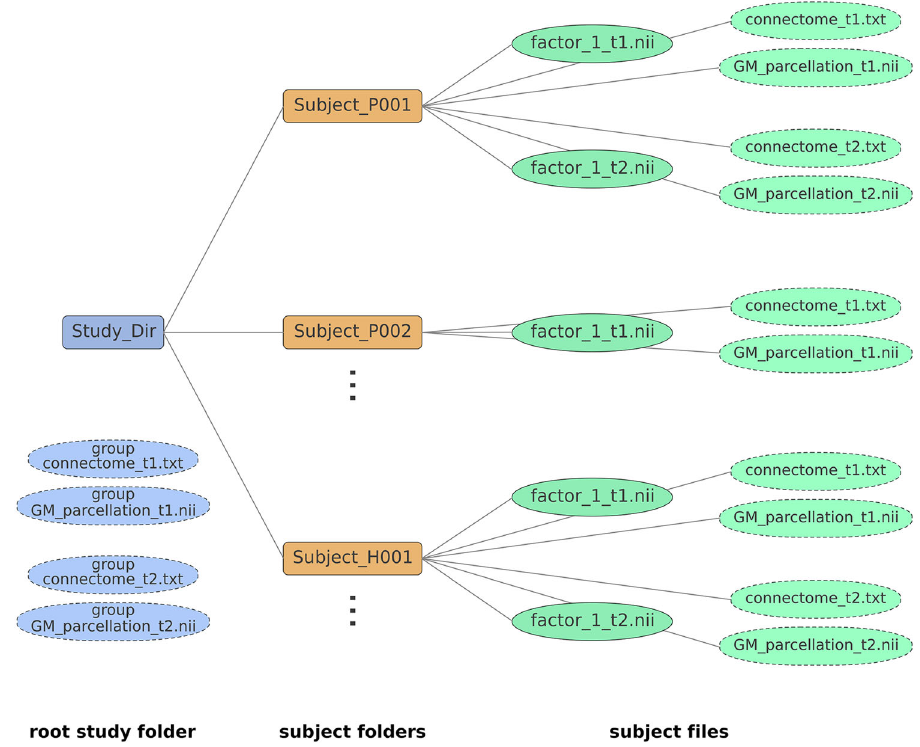
Fig. 6 Schematic for data organization in an ESM study. As mentioned, if the brain parcellation(s) and/or connectivity information are only available at the group level (e.g. coming from a template or another study), the parcellation(s) and/or connectome fi les can be, alternatively, saved at the root folder containing all the subjects. Please be sure to include at least one connectome matrix for the fi rst modality, with same number of rows and columns (i.e. regions) that your